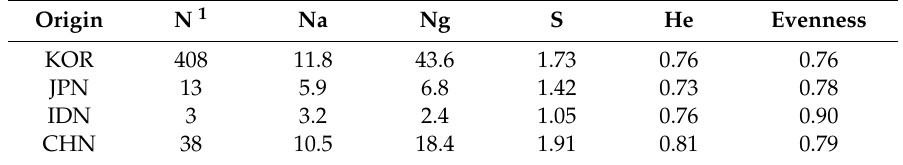
Table 4. Genetic diversity parameters of the four origins in the 462 tea accessions using 33